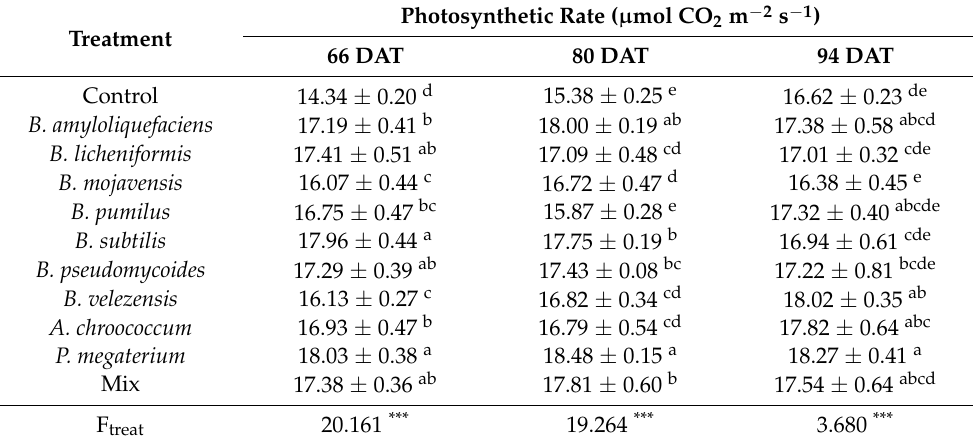
Table 4. Effect of PGPB strains on photosynthetic rate 66, 80, and 94 DAT.